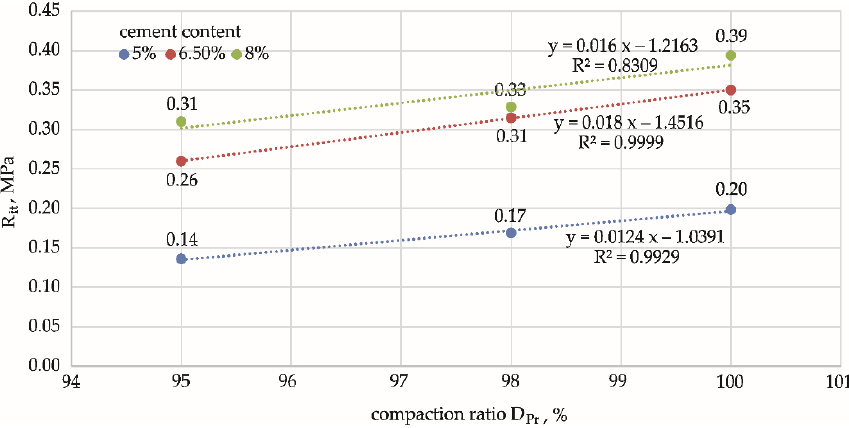
Figure 8. Effect of compaction ratio, 𝐷 𝑃𝑟 , on indirect tensile strength, 𝑅 𝑖𝑡 , for mixtures with different cement contents. Cement content: 5%, 6.5%, 8%